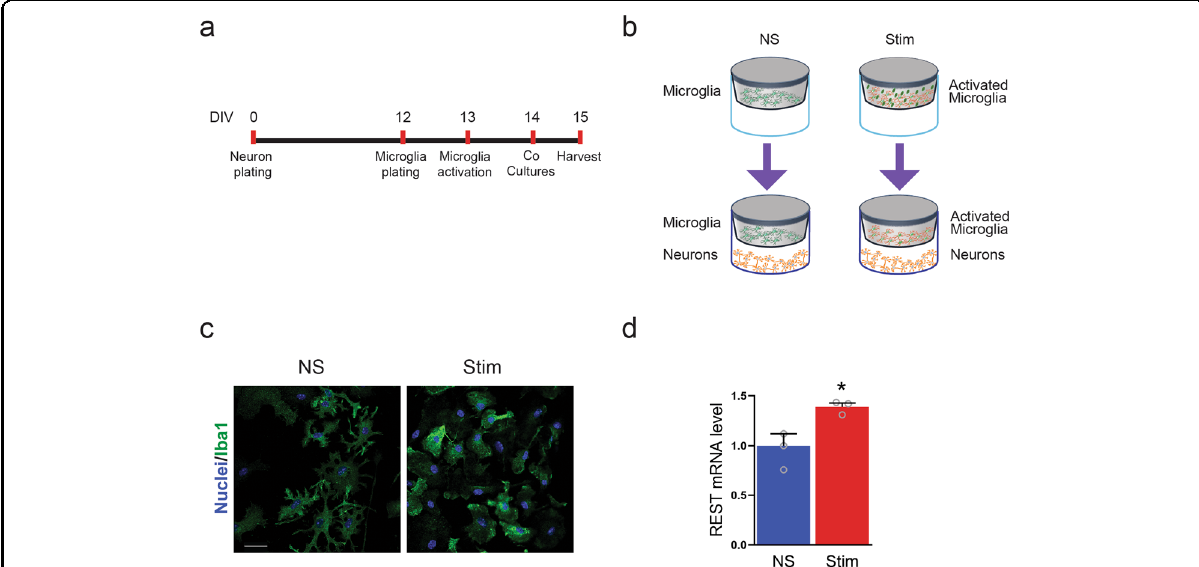
Fig. 2 Contactless co-cultures of neurons and stimulated microglia increases the neuronal expression of REST. a , b Timeline ( a ) and schematics ( b ) of the experimental procedures for the contactless microglial/neuronal co-cultures. Primary microglial cells were harvested from the mixed primary glial cultures at 18 DIV and seeded on matrigel-coated Transwells TM for 1 day before being treated for 24 h with either LPS (Stim) or vehicle (NS). After treatment, microglia-coated transwells were added to 14 DIV primary cortical neurons that were harvested 24 h later. c Microglial activation was veri fi ed by staining with the microglial marker Iba1. DAPI-stained nuclei are shown in blue. Scale bar, 25 µm. d After 24 h of contactless co-culture with either control or activated microglia, Transwells TM were removed and neurons were harvested and subjected to qRT-PCR to assess the full-length REST expression. Gapdh, Actin, and Hprt1 were used as housekeeping genes. Bars show mean ± sem with superimposed individual points obtained from three independent preparations. Similar to activated T cell supernatant, the secretory activity of activated microglia increases REST expression in the co-cultured neurons. * p < 0.05; Mann – Whitney U